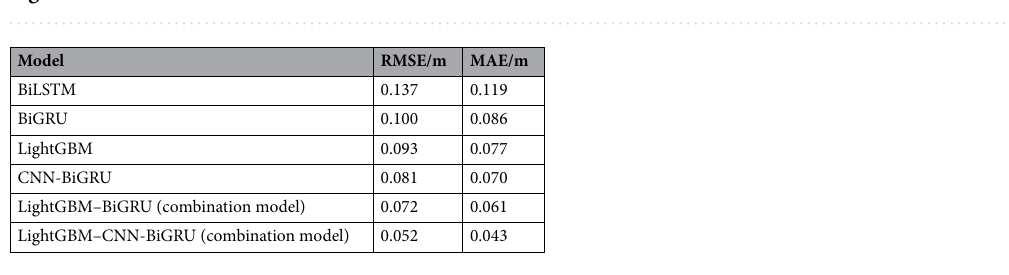
Table 2. Prediction effects of different models on the Howth Harbor